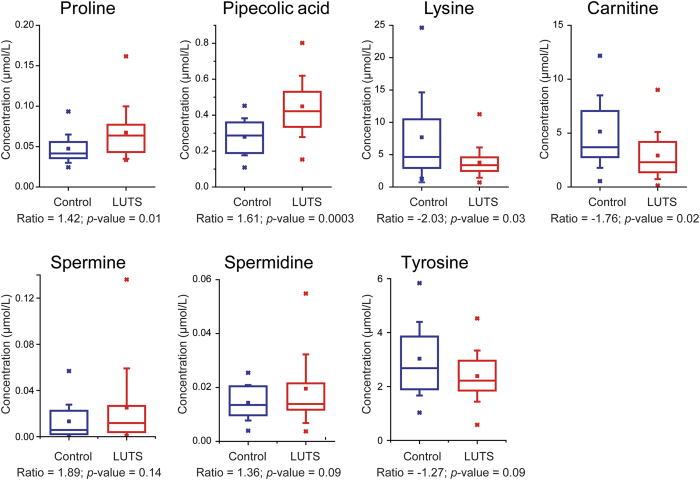
Box plots of absolute quantification of selected metabolites in urine.Each box contains the metabolite concentrations from 26 (LUTS) or 20 (Control) urine samples. Box denotes 25th and 75th percentiles; line within box denotes 50th percentile; whisker denotes standard deviation.